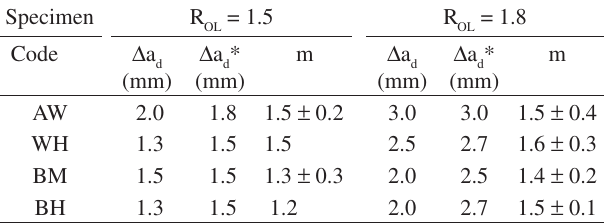
* and m as determined for the Wheeler d = 1.5 R OL